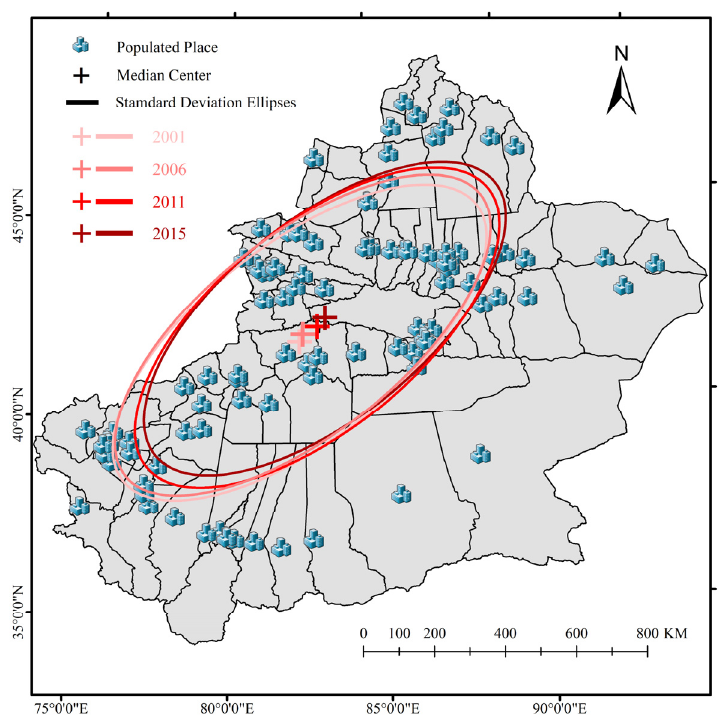
Figure 5. Spatial changes of the median center and standard deviation ellipses of PM 2.5 concentrations.